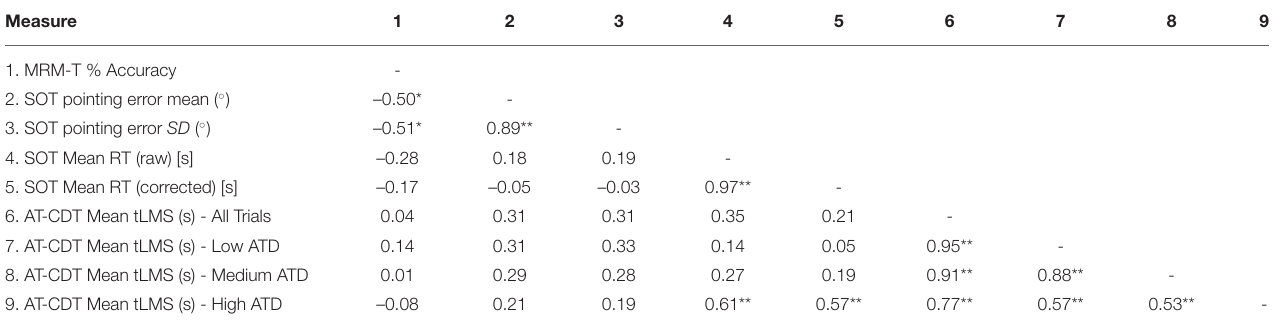
TABLE 3 | Bivariate correlations of key test variables of interest ( N = 20). Measure